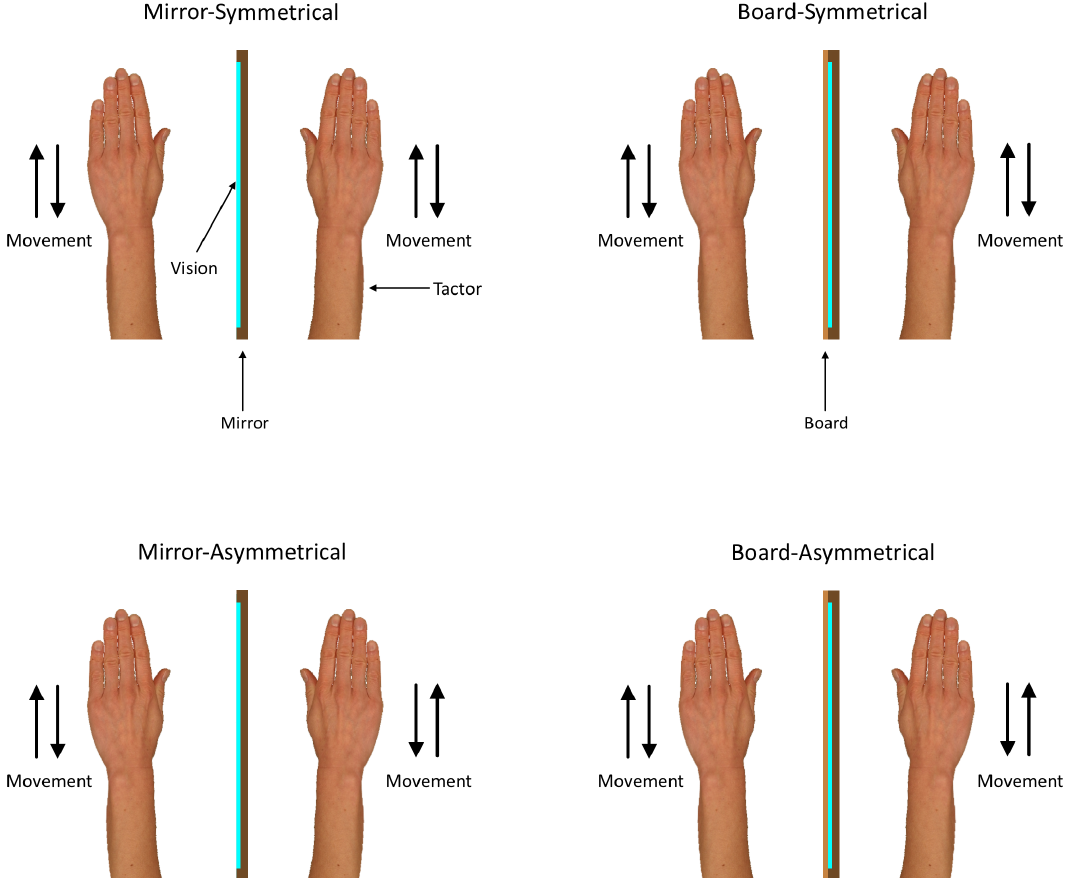
Fig 1. Representation of the four experimental conditions. The direction of vision and the position of the tactile stimulator were the same for all conditions.